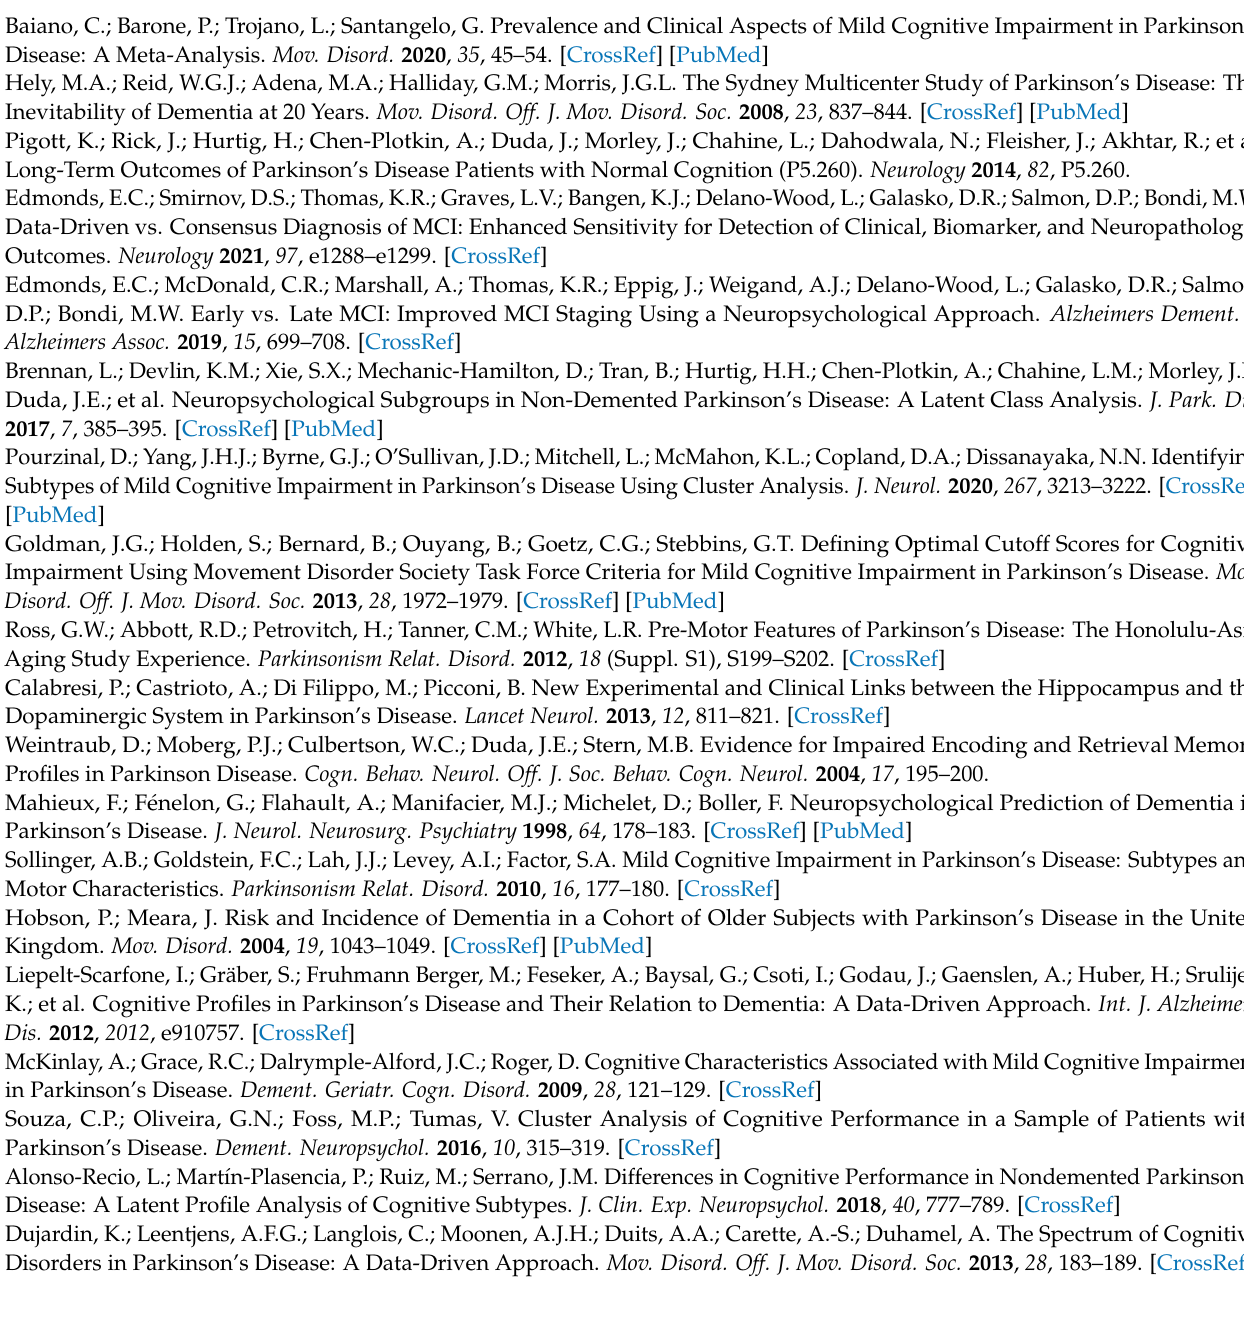
Table A3 shows mean scores of BNT and semantic fluency (Animals) across the 3 clusters. Results of a between (cluster) x within (language measure) repeated measures ANOVA revealed a significant main effect of language measures ( F (1.00, 491.00) = 95.94, p < 0.001, n p 2 = 0.16) where semantic fluency was significantly lower than confrontation naming (M = − 0.65, p < 0.001). The main effect of cluster was also significant ( F (2, 433.61) = 202.84, p < 0.001), with the Cognitively Average cluster performing significantly better than the Low EF cluster (M difference = 0.87) who in turn scored better than the Prominently Impaired EF/Memory cluster (M difference = 0.78), with all p values < 0.001. The cluster x language measure interaction was nonsignificant ( F (2.00, 491.00) = 0.50, p > 0.05, n p 2 = 0.002). Thus, all clusters demonstrated similar patterns of worse semantic fluency performance relative to confrontation